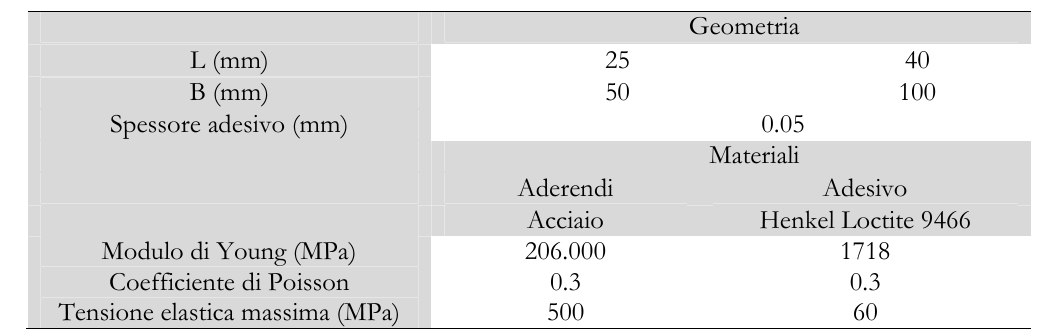
Figura 1: Schema della struttura tubolare incollata (a) e del tubo quadro integro (b)